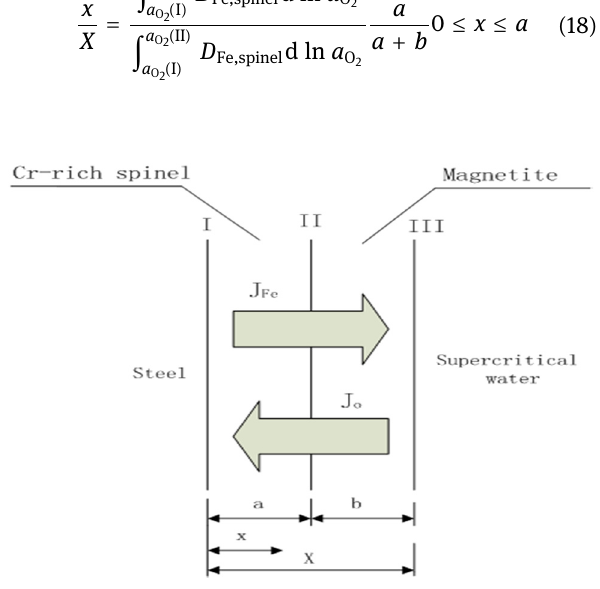
Figure 1: Schematic diagram of iron and oxygen diffusion in mag - netite layer and spinel layer